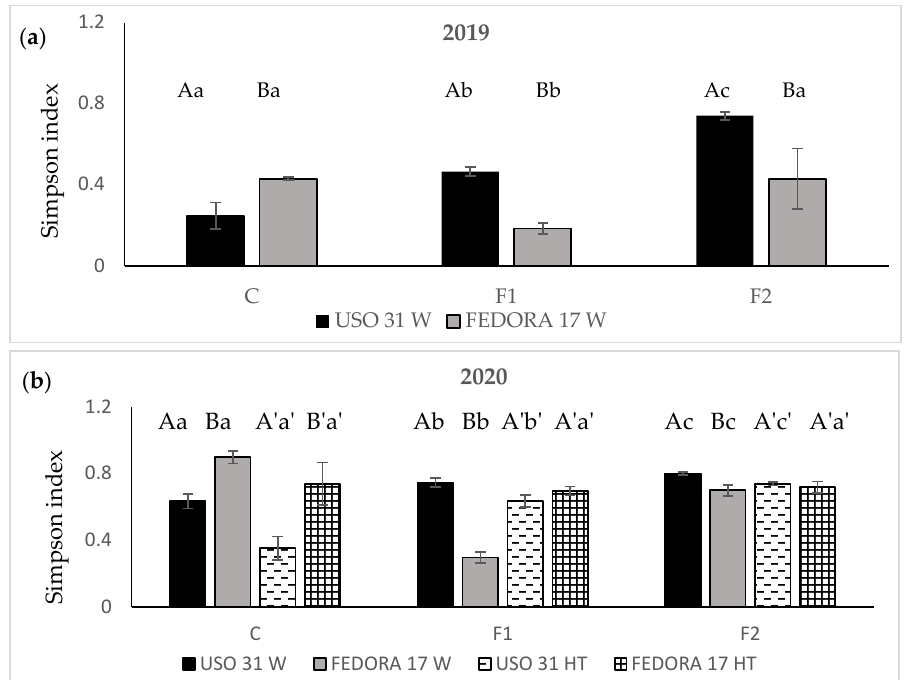
Figure 4. Simpson index of weeds in hemp crop during the growing season 2019 ( a ) and the growing season 2020 ( b ). Vertical bars indicate the standard errors of the means. Values without a common le tt er are statistically signi fi cant according to LSD (0.05).